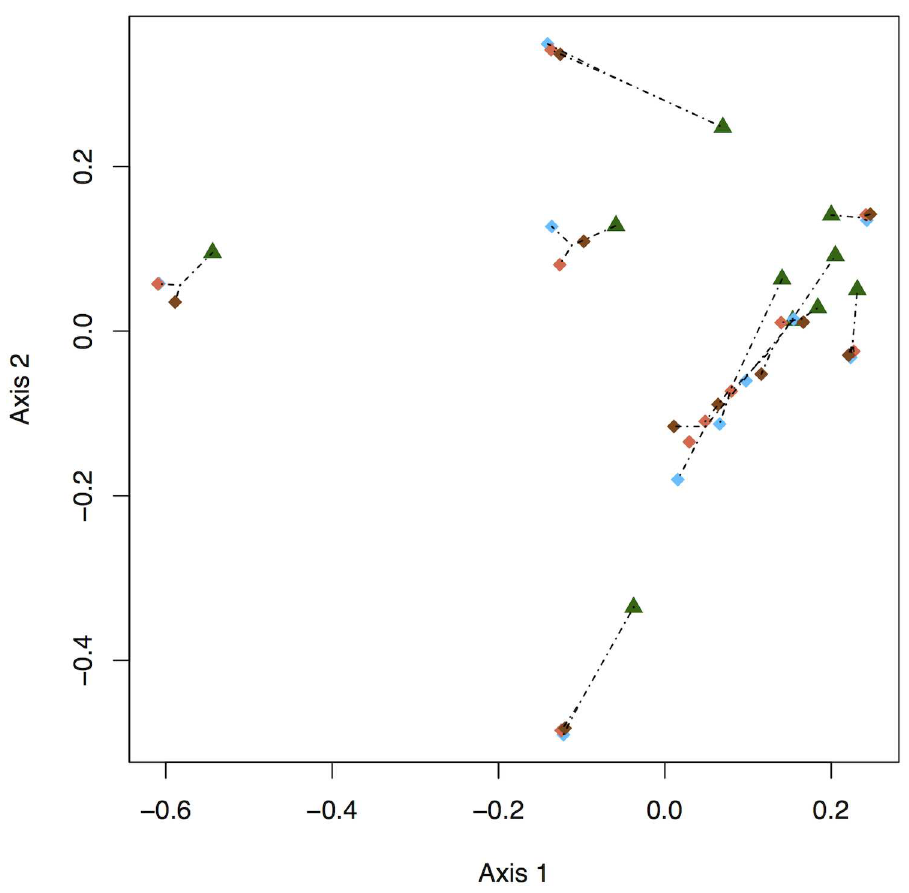
Fig 2. Principal coordinates plot of the home range estimators for 10 individual proboscis monkeys. Dotted lines indicateHellinger distance, showing the differencesbetweenthe ranges produced by four home range estimators (GCM, green triangle; a-LoCoH, blue; T-LoCoH, orange;and BRB,